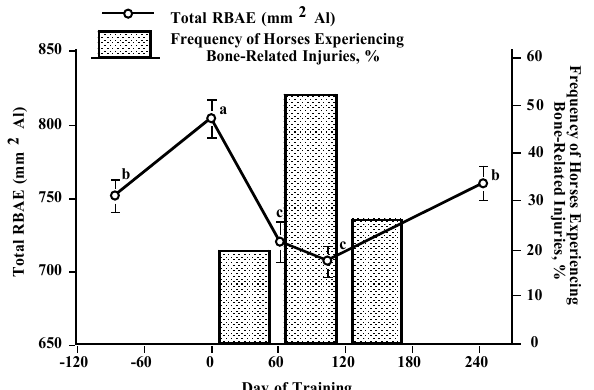
Figure 1. Total radiographic bone Al equivalences (RBAEs) of all horses and periods during which bone-related injuries occurred [21]. a,b,c Days lacking a common superscript differ ( p < 0.05).